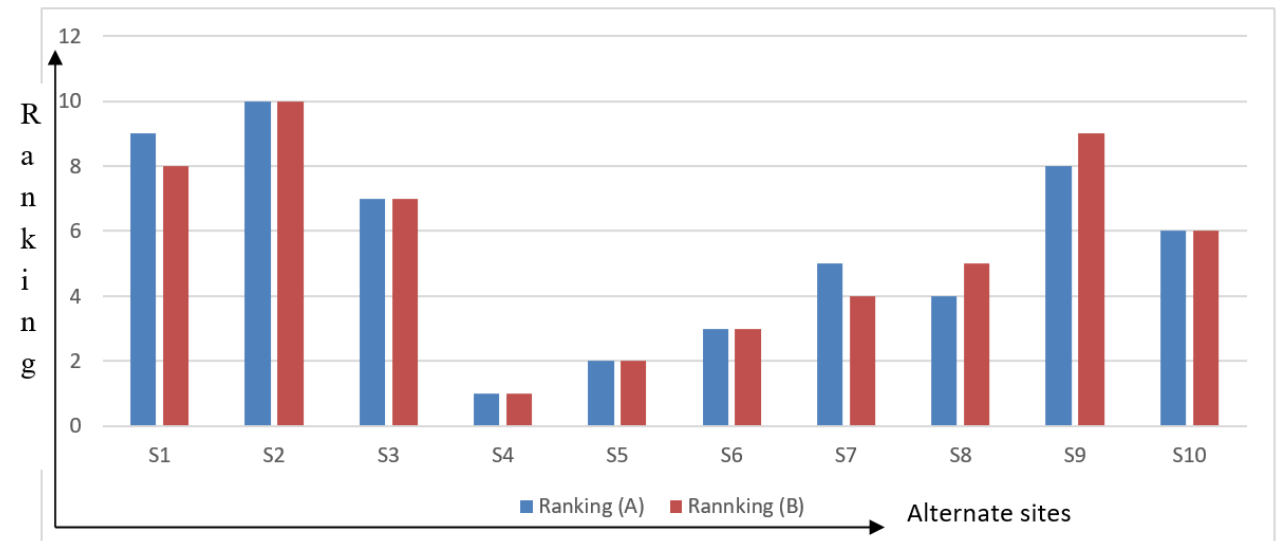
Figure 11. Sensitivity analysis ranking obtained under fuzzy AHP-TOPSIS. Figure 11, i.e., ranking obtained by fuzzy AHP-TOPSIS under sensitivity